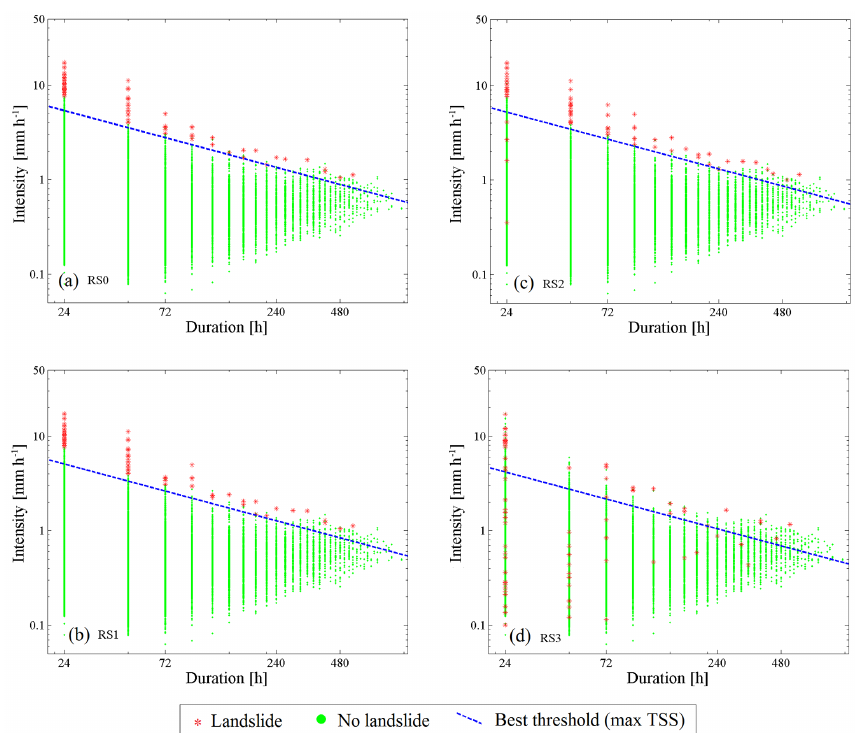
Figure 6. Scatter plot, in the double-logarithmic rainfall duration–intensity plane, of triggering and non-triggering events for daily data and separation algorithm parameters u min = 1 day, s min = 0. Thresholds correspond to the maximum performance in terms of true skill statistic. The plots show outcomes relative to (a) reference RS0 and (b–d) various erroneous reporting scenarios (RS1, RS2, RS3). Table 6. Threshold calibration results for all simulations, in the case of nulled effects of antecedent precipitation ( τ M = 0). RS0 RS1 RS2 RS3